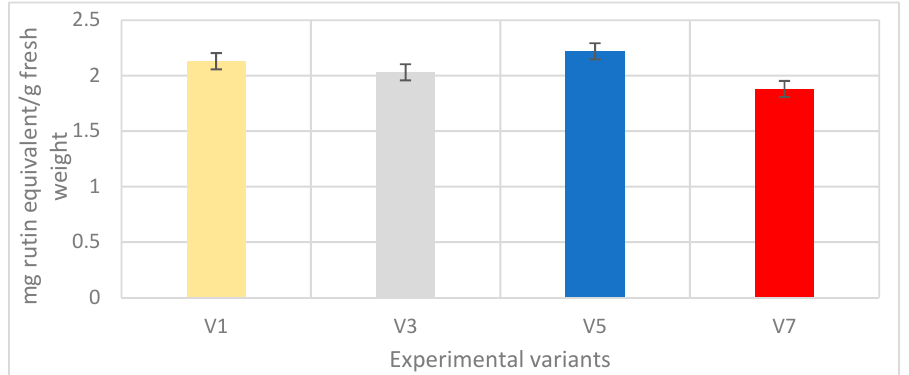
Figure 6. The flavonoid concentration in Lepidium sativum L. sprouts on gauze substrate (V1 control, illuminated with sunlight; V3, illuminated with white LED; V5, illuminated with blue LED; and V7, illuminated with red LED experimental variants). Data acquired from the experiment were statistically investigated and were expressed as the mean ± SD (standard deviation). Bars are one standard deviation. Table 6. A one ‐ way ANOVA test for flavonoid concentration in Lepidium sativum L. sprouts. Substrate (gauze) p ‐ Value F F cri t V1, V3, V5, and V7 experimental variants